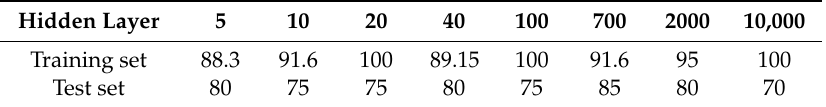
Table 8. Accuracy with different hidden layer (%).